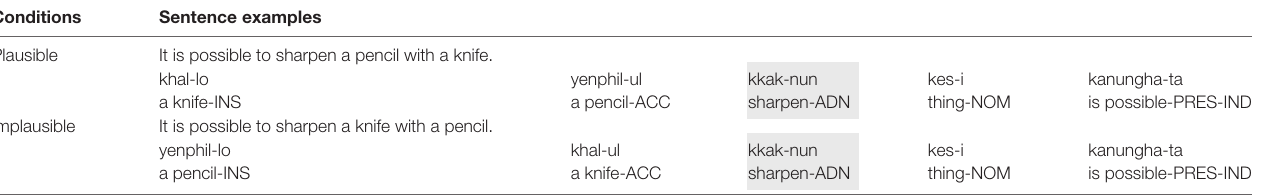
TABLE 1 | Sentence examples for the experimental